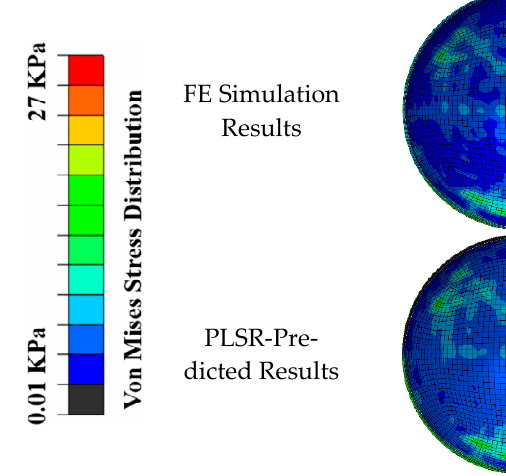
Figure 5. Comparison of FE simulated von Mises stress pattern and PLSR-predicted von Mises stress (soccer ball velocity was 35 mph with diagonal impact location). General agreements can be seen in the location and magnitude of maximum stress.